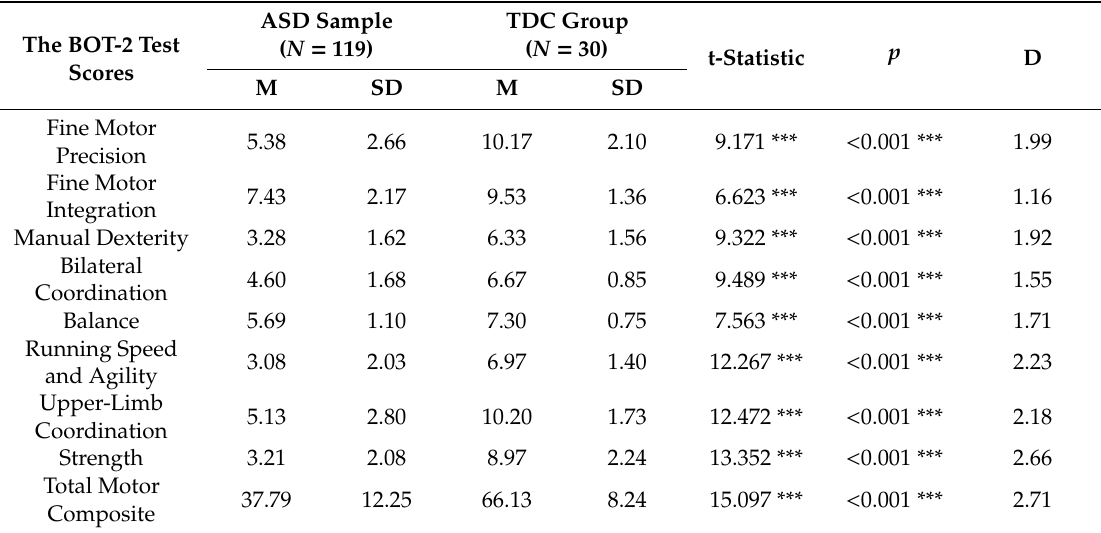
Table 4. Comparison of the autism spectrum disorder and typically developing groups based on the BOT-2 raw scores and total motor